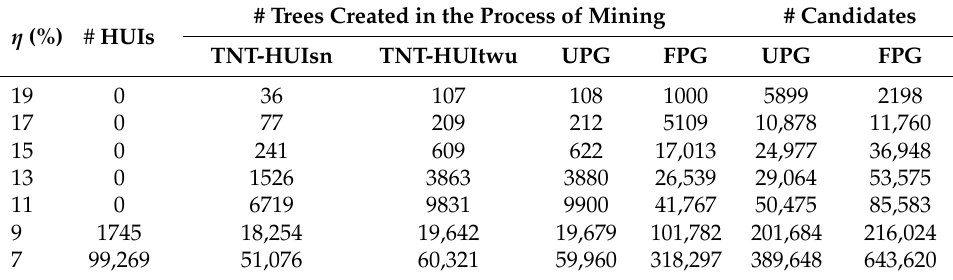
Table 5. Details analysis on the dataset mushroom.